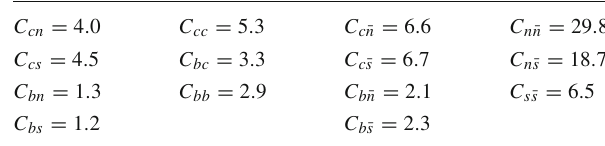
Table 2 Relevant coupling parameters in units of